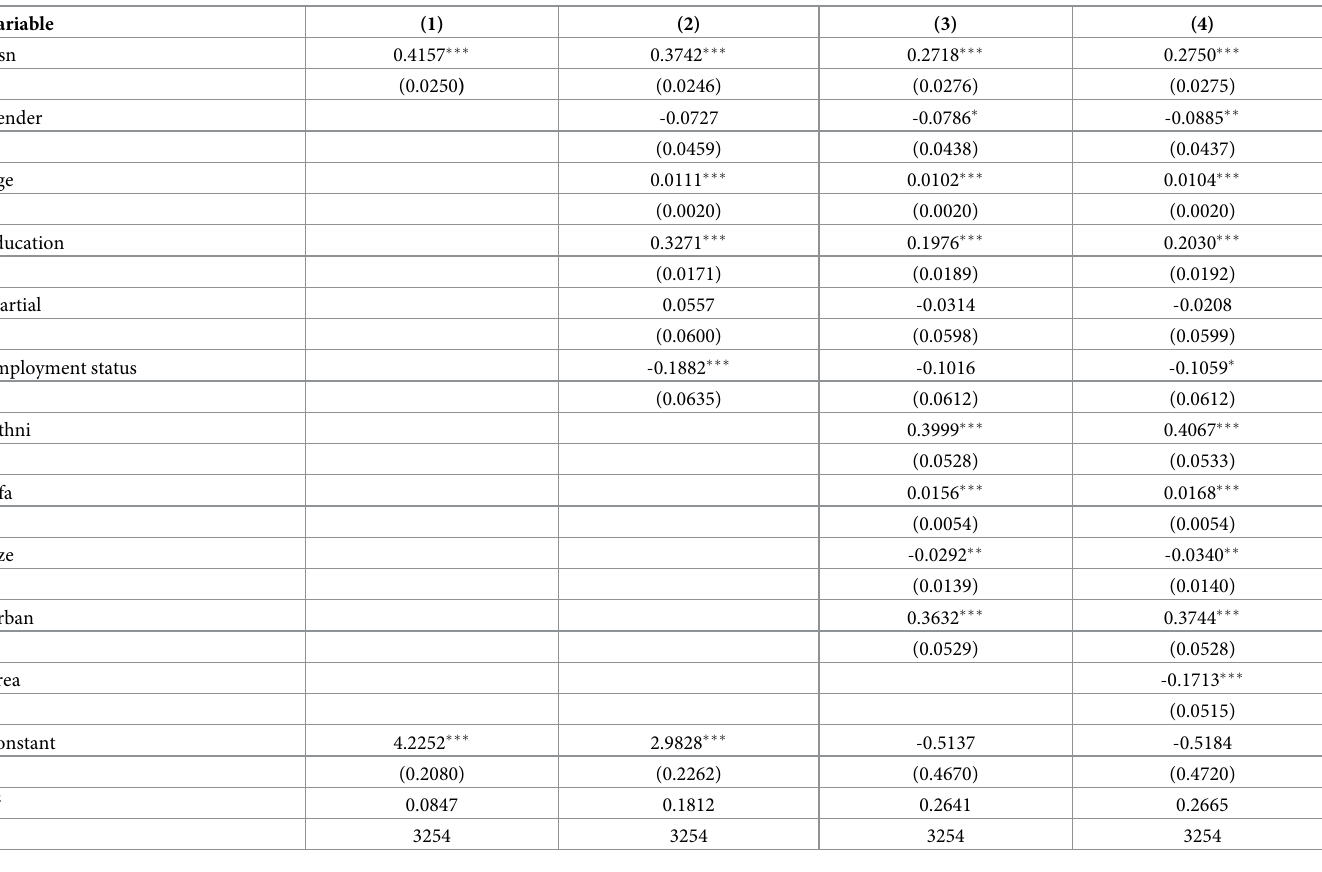
Table 2. Impacts of social networks on household tourism